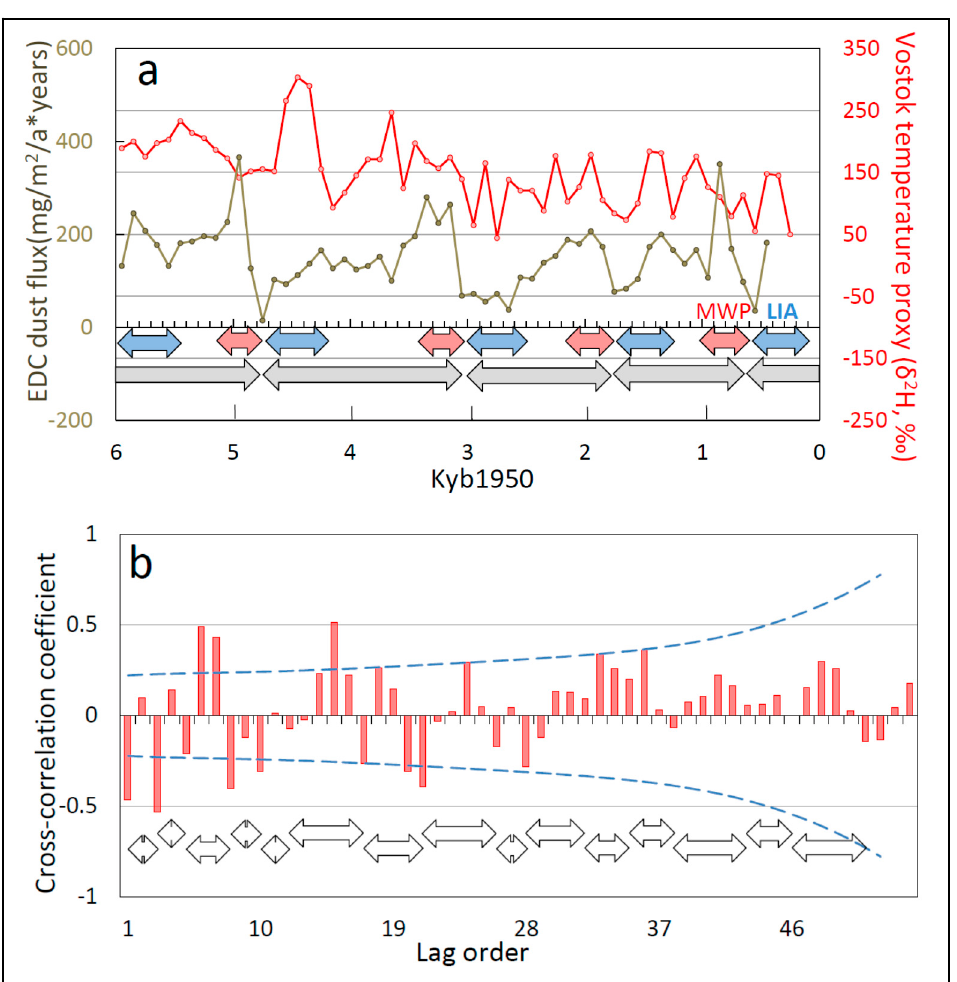
Figure 8. Integrated temperature-proxy and wind-proxy time series over six millennia in 100-year intervals. ( a ) relationship with recurrent warm / cold cycles of the past, including the Medieval Warm Period (MWP) and the Little Ice Age (LIA) and their earlier homologs (double-headed red and blue arrows, respectively). ( b ) Cross-correlogram of temperature-proxy and wind-proxy records showing a weak but discernible relationship, as signified by the finding that cross-correlation coe ffi cients at cycle peaks reach significance in half the cycles. The dashed blue lines in part b represent 95% confidence limits (positive and negative) for the value of the correlation coe ffi cient associated with di ff erent lag orders (sample sizes). Additional abbreviation: Kyb1950, thousand years before